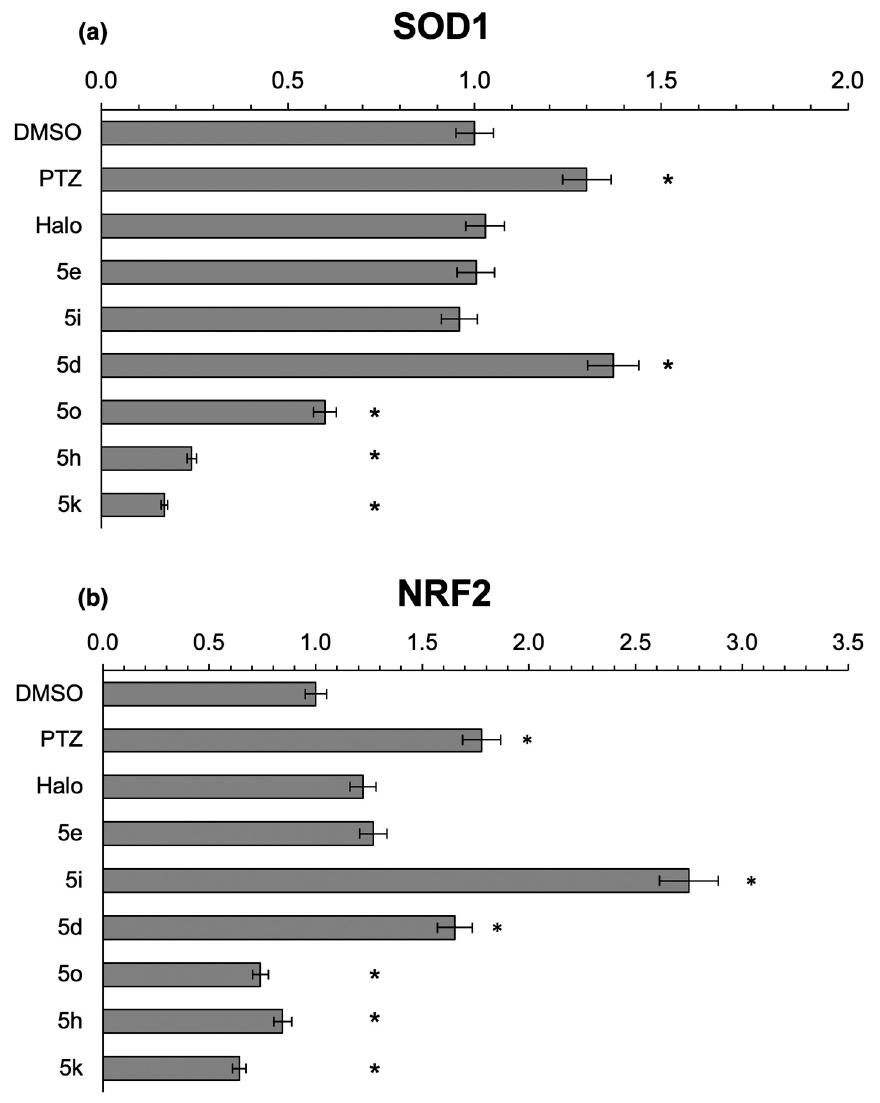
Figure 4. Effects of the novel ifenprodil analogs on SOD1 and NRF2 gene expression in SH-SY5Y cells. Cells were treated with pentazocine, haloperidol, or ifenprodil analogs 5e , 5i , 5d , 5o , 5h , and 5k (at a concentration of 12.5 µM) for 12h, mRNA was extracted, and quantitative RT-PCR was performed to show the levels of SOD1 ( a ) and of NRF2 ( b ) transcripts. All data represent the mean ± SE from triplicate independent experiments. * p < 0.05 vs. DMSO 1% control.